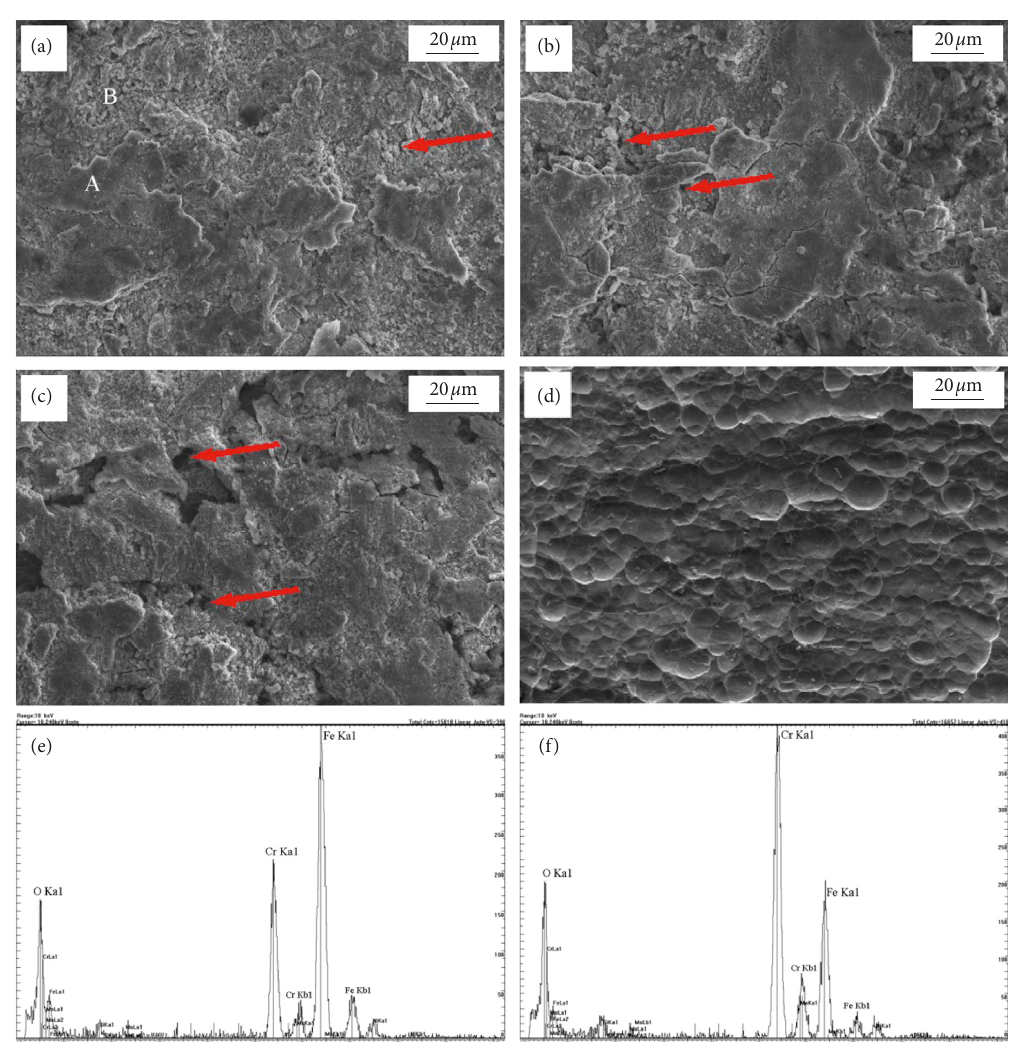
Figure 4: SEM images of the oxide scales after immersion in the pickling electrolyte for 30 s (a), 60s (b), and 90s (c), respectively. The matrix after pickling (d) and EDS spectrums corresponding to points A (e) and B (f) in (a),